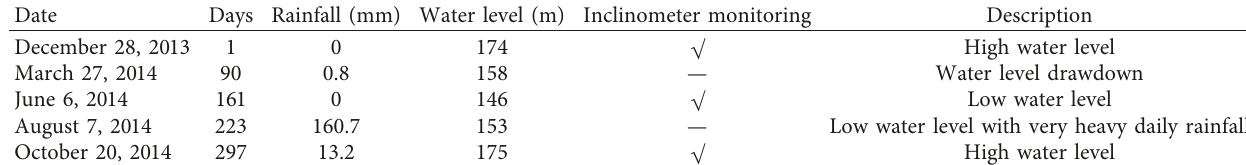
Table 4: Representative points in time and